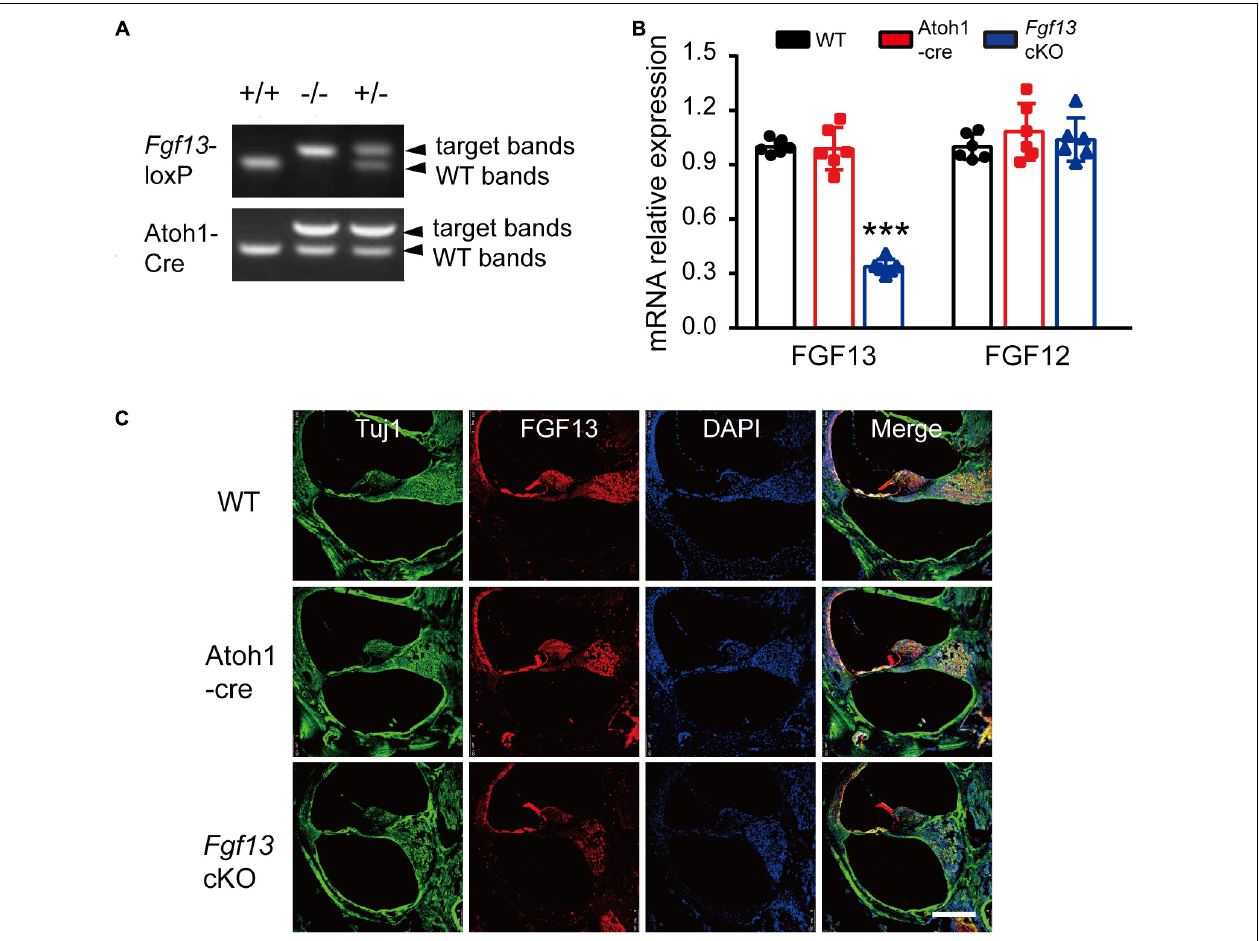
FIGURE 2 | Generation of inner ear conditional knockout Fgf13 mice using the loxP-Cre system. (A) PCR genotyping of wild-type (+/+), homozygote (–/Y or–/–), and hemizygous (+/–) Fgf13 knockout mice using genomic DNA prepared from tail biopsies. (B) qRT-PCR of FGF13 and FGF12B. Expression levels were normalized to endogenous GAPDH. Each expression level was standardized to WT and given a value of 1. *** P < 0.001 compared to WT as determined by One-Way ANOVA. (C) Confocal images of FGF13 (red) and Tuj1 (green) in the base of the cochlea. Scale bar = 200 µ